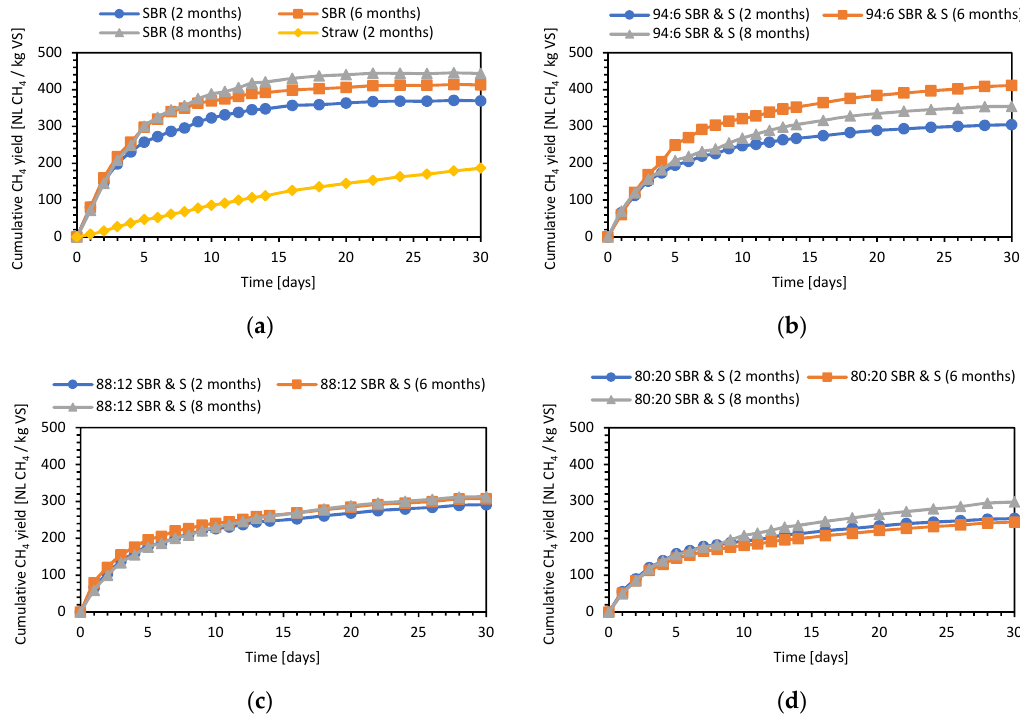
Figure 3. Cumulative CH 4 yield of ( a ) mono-ensiled samples of sugar beet root (SBR) and dry-stored straw (S), ( b ) co-ensiled SBR and S (94:6), ( c ) co-ensiled SBR and S (88:12), ( d ) co-ensiled SBR and S (80:20), at different ensiling periods.